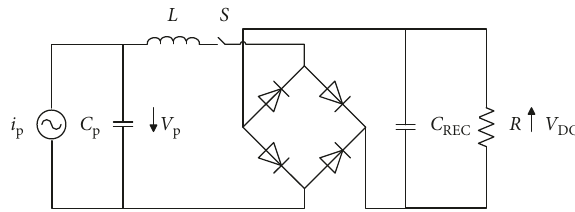
Figure 3: Schematic of the series synchronized switch harvesting on inductor circuit.